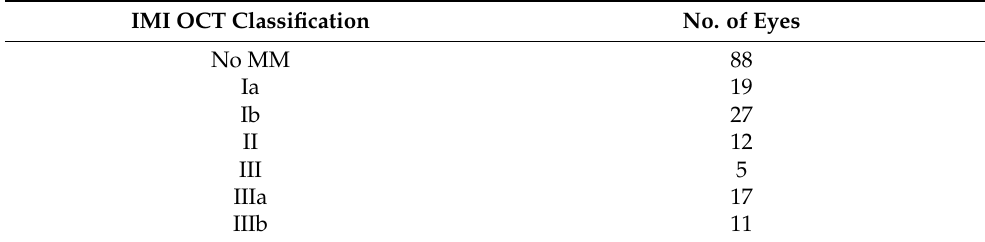
Table 2. Number of Eyes in Each Category of the IMI OCT